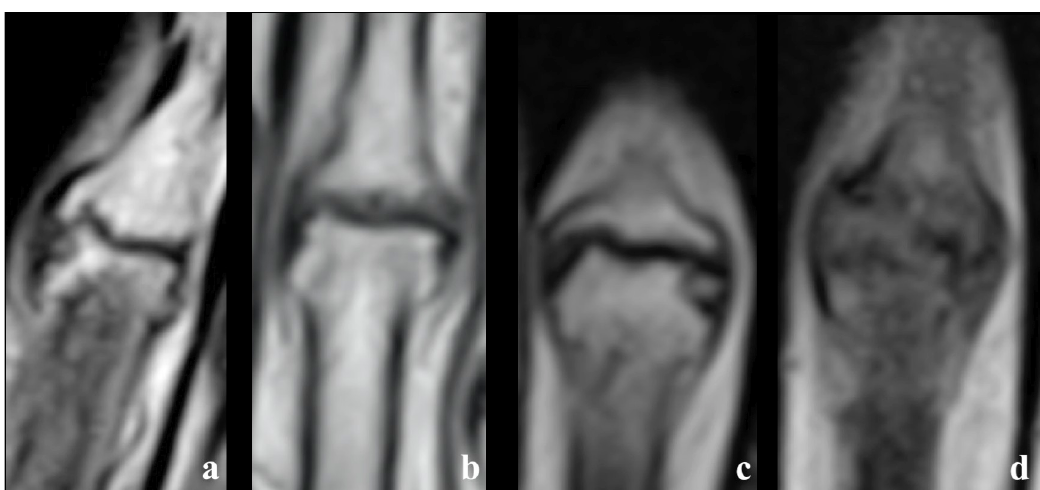
Fig 1. MRI joint structural features. a.: osteophytic feature (O) b.: erosive feature (E) c.: erosive and osteophytic lesion feature (E/ O) d.: complete articular destruction